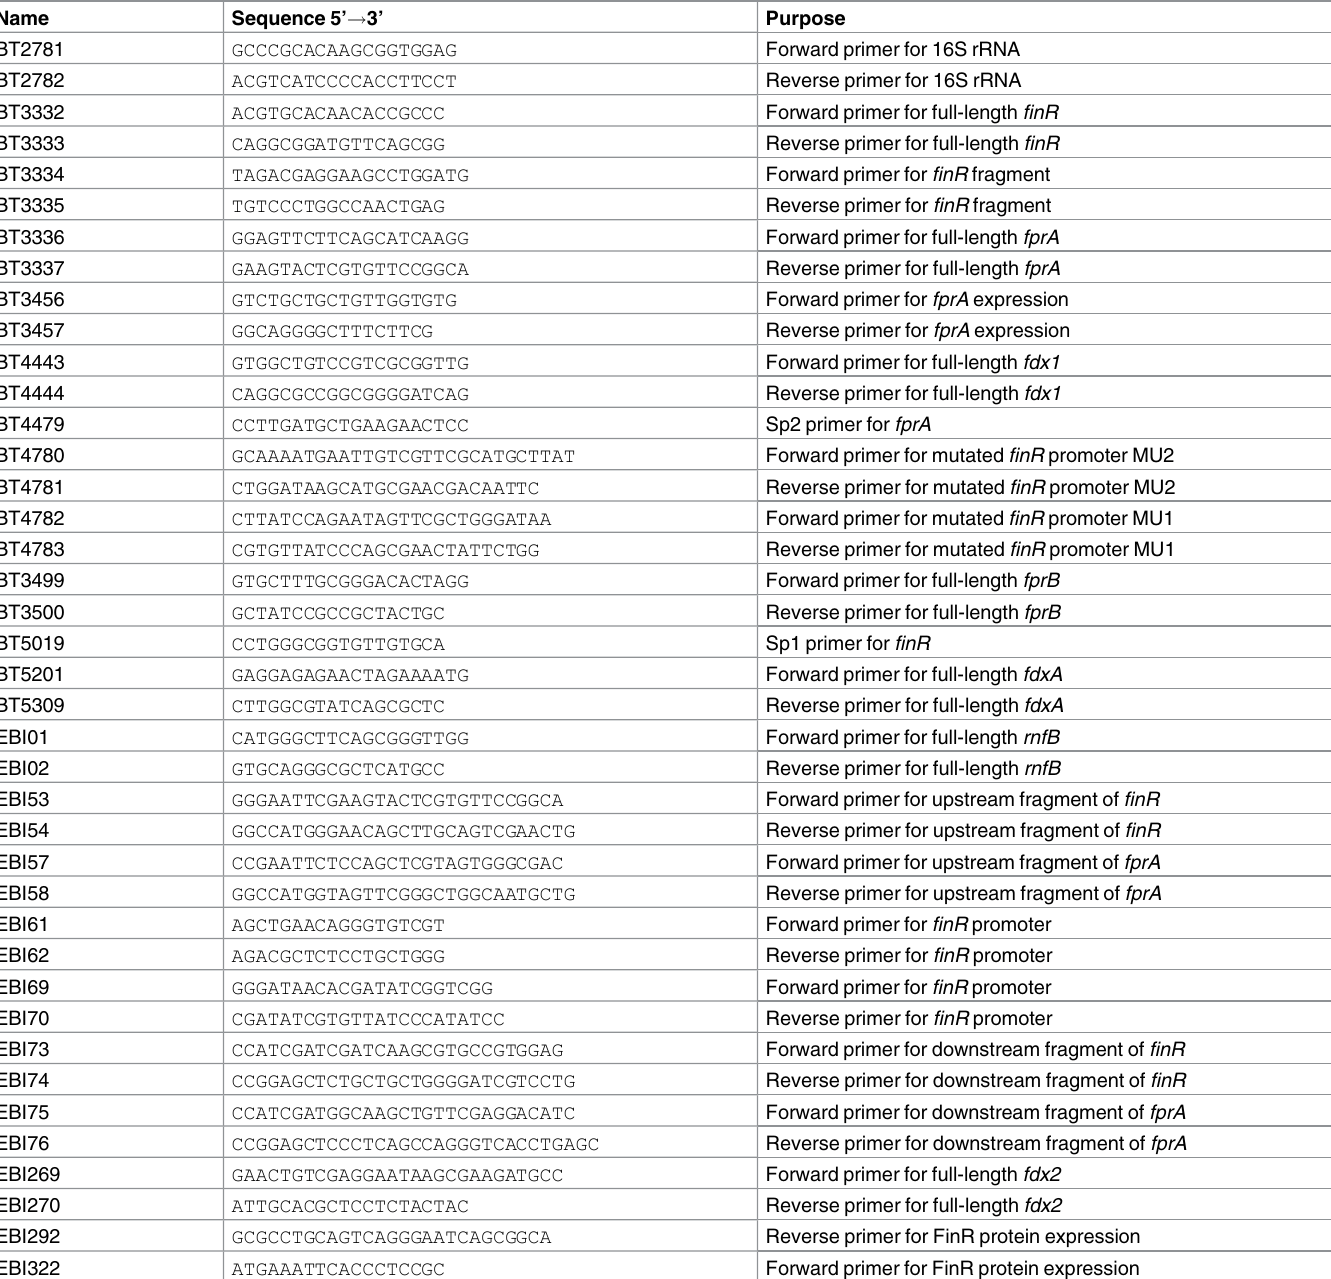
Table 3. List of primers used in this